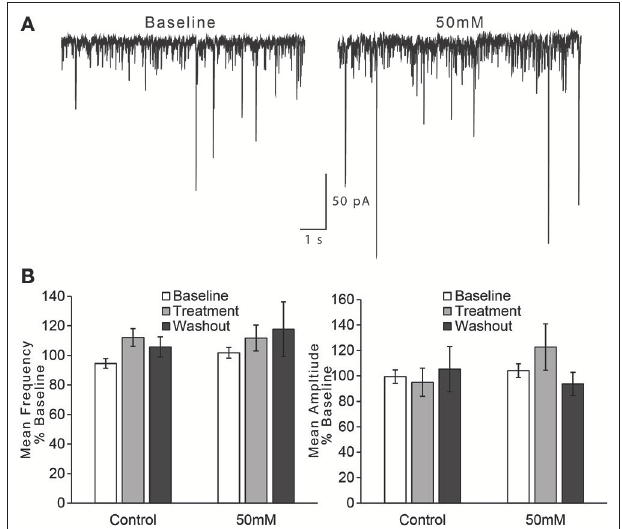
FIGURE 5 | Ethanol has no effect on spontaneous GABA IPSCs in AIC layer 2/3 pyramidal neurons. (A) Representative traces from a single neuron showing spontaneous IPSCs (sIPSCs) before and after treatment with acute ethanol (50mM). (B) Summary charts showing mean frequency (left) and amplitude (right) of sIPSCs during the last 2min of each period of the experiment (Baseline, Treatment, and Washout), expressed as a percentage of the entire 10min baseline average. Values are expressed as averages ± S.E.M (Control, n = 6 neurons/6 slices/6 mice; 50mM, n = 11 neurons/11 slices/9